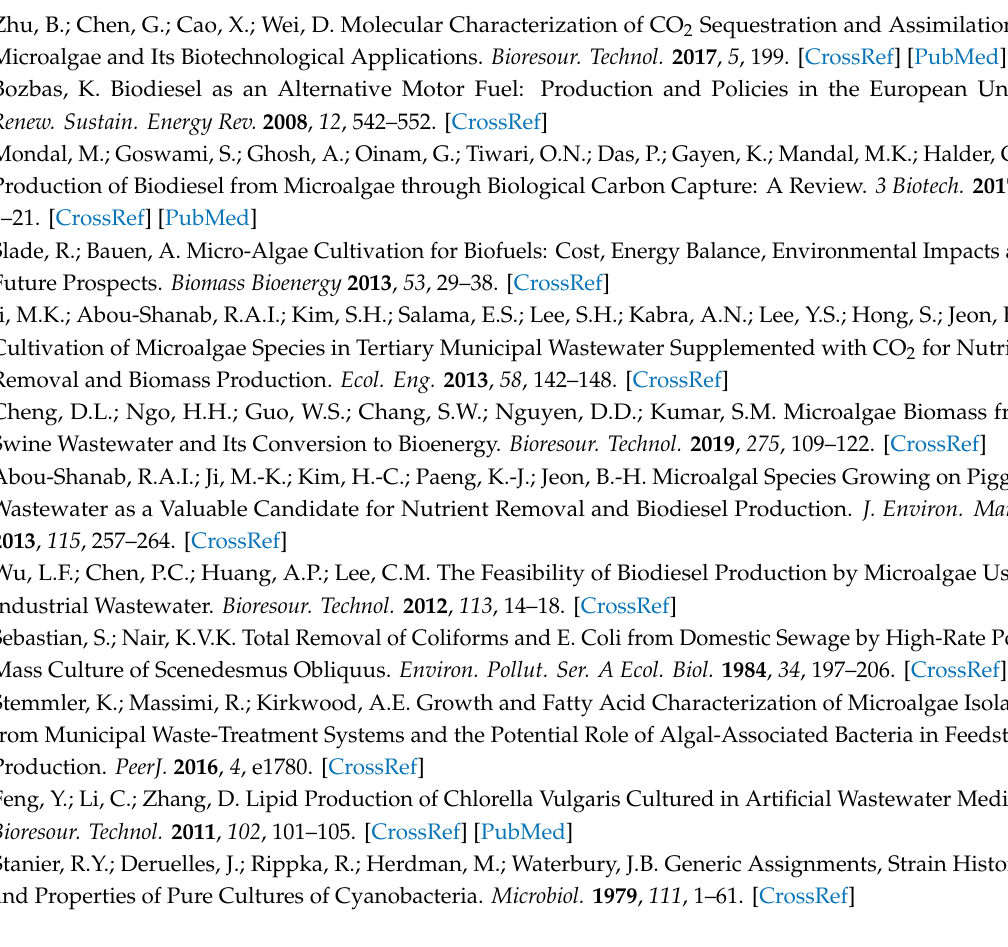
Figure S1: Screening of 20 KNUA microalgal strains on artificial wastewater agar medium. Table S1: Total nitrogen, ammonia, and total phosphorus removal rate of microalgal strains. The word in the parenthesis indicates the days which each strain achieved the maximum total nitrogen removal. Table S2: Fatty acid profile of microalgal biomass in treated primary settled